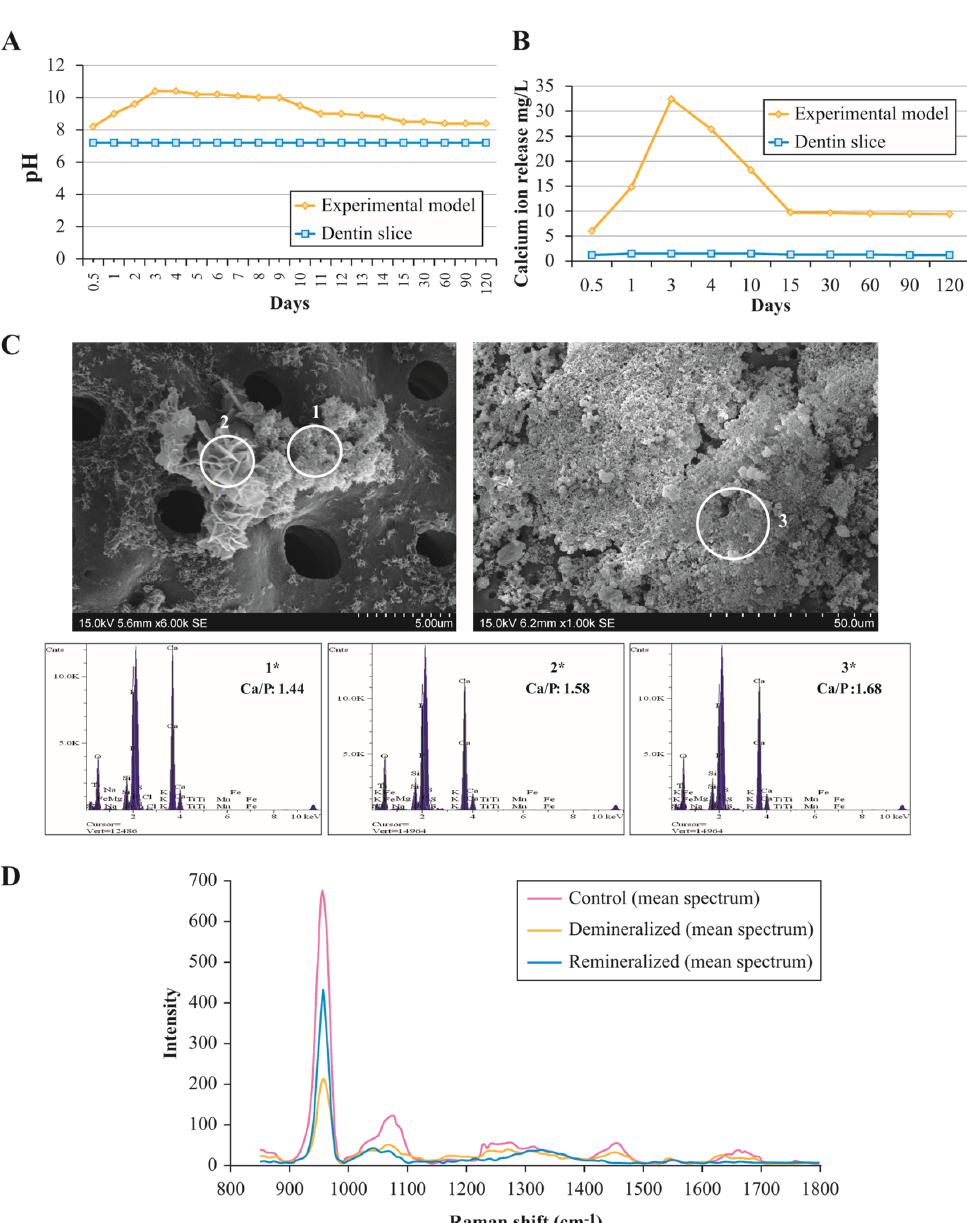
Figure 1. Composition and ultrastructure evaluation of biomimetic remineralisation system. ( A ) pH profiles of solutions. ( B ) Calcium ion release profile. ( C ) Morphological characterisation of precipitates by scanning electron microscopy (SEM). (1) Energy dispersive X-ray analysis (EDAX) spectrum for acicular precipitates and semi-quantitative chemical composition showing a Ca / P molar ratio of 1.44, which could be related to the transformation of the metastable amorphous calcium phosphate phase into the apatite phase. (2) Petal-like precipitates (6000 × ) and EDAX, revealing a greater Ca / P molar ratio of 1.58. The petal-like precipitates are likely to represent octocalcium phosphate, a mandatory precursor for the formation of carbonated apatite. (3) Compact lath-like precipitates (1000 × ) and EDAX, revealing a greater Ca / P molar ratio of 1.68, compatible to carbonated apatite. ( D ) Micro-Raman mean spectra obtained from control dentin, demineralised dentin, and remineralised dentin. The predominant bands at 955 and 1063 cm − 1 attributed to the bending vibration of ν 1 (PO 43 − ) within hydroxyapatite crystals denote a lower intensity in remineralised dentin and an even lower intensity in demineralised dentin compared with untreated dentin. Raman bands at 1454 cm − 1 assigned to CH 2 deformation of the matrix collagen seem to disappear in the spectra of remineralised dentin compared to demineralised dentin, suggesting that our model achieved complete deposition of the mineral layer (remineralisation) over the collagen